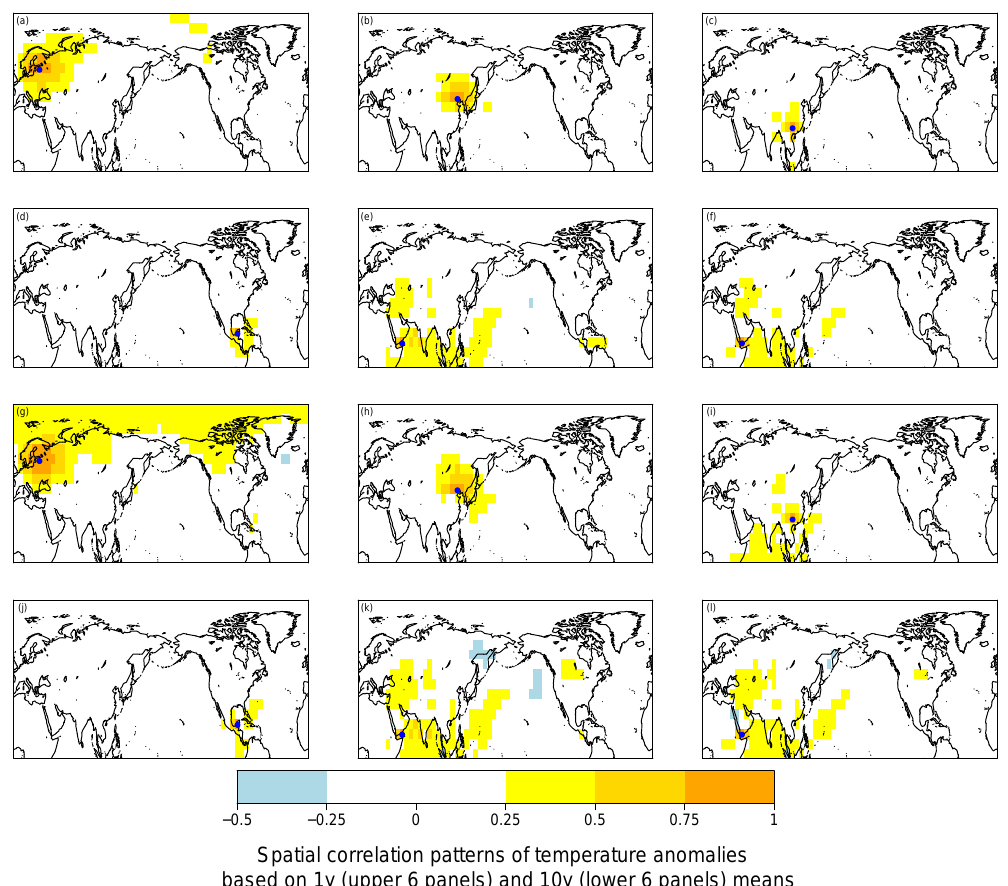
Fig. 2. Spatial correlations of annual anomalies at specified grid points (corresponding to the locations of the longest data time series).